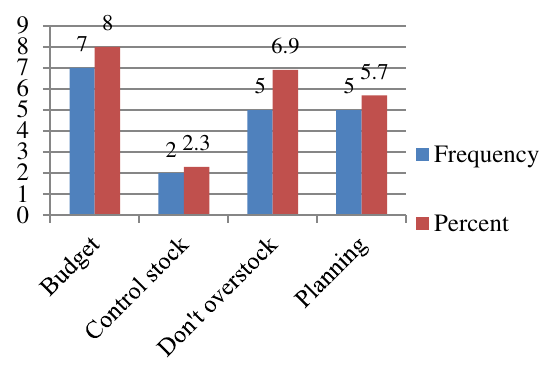
Fig. 12. What advice do you give other SMEs to avoid from financial crisis?